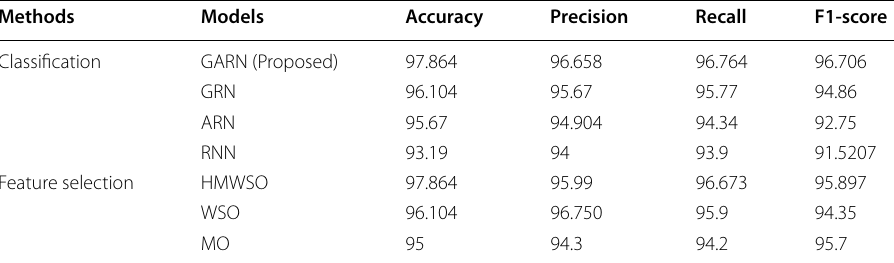
Table 10 Result analysis related to ablation experiment Methods